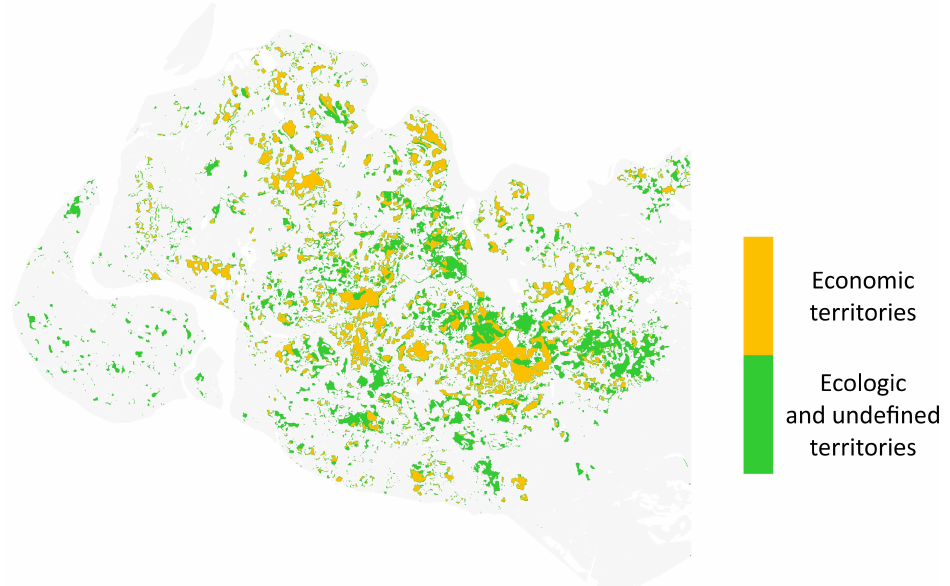
Figure 18. The territory that lost the stability of flooding for the period